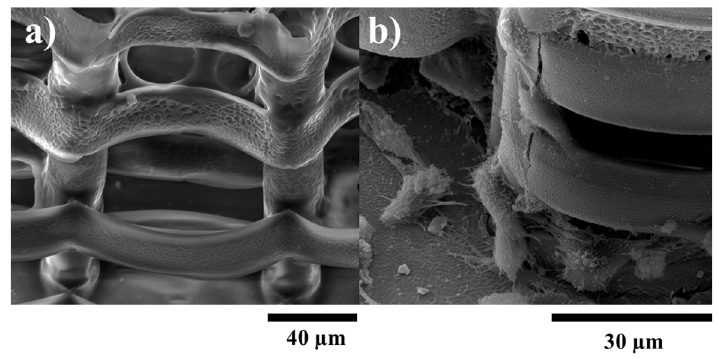
Figure 6. SEM (scanning electron microscopy) micrographs of: ( a ) 3D structures coated with Col-Chit-HA-MNPs (Collagen-Chitosan-Hydroxyapatite-Magnetic nanoparticles); ( b ) MG-63 cells growing on the magnetic structures.